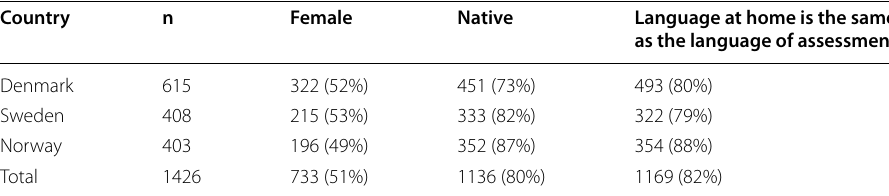
as the language of assessment